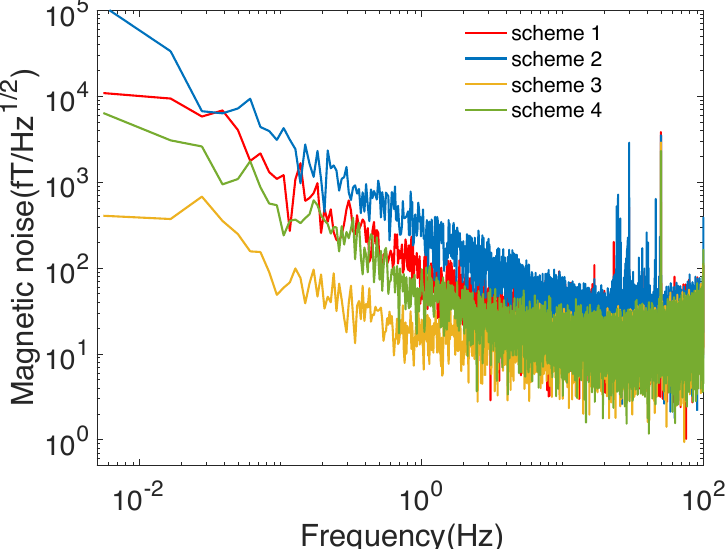
Figure 4. Magnetic noise measurement results of the SERF magnetometer under inner magnetic shield layers of different amorphous alloys and nanocrystalline